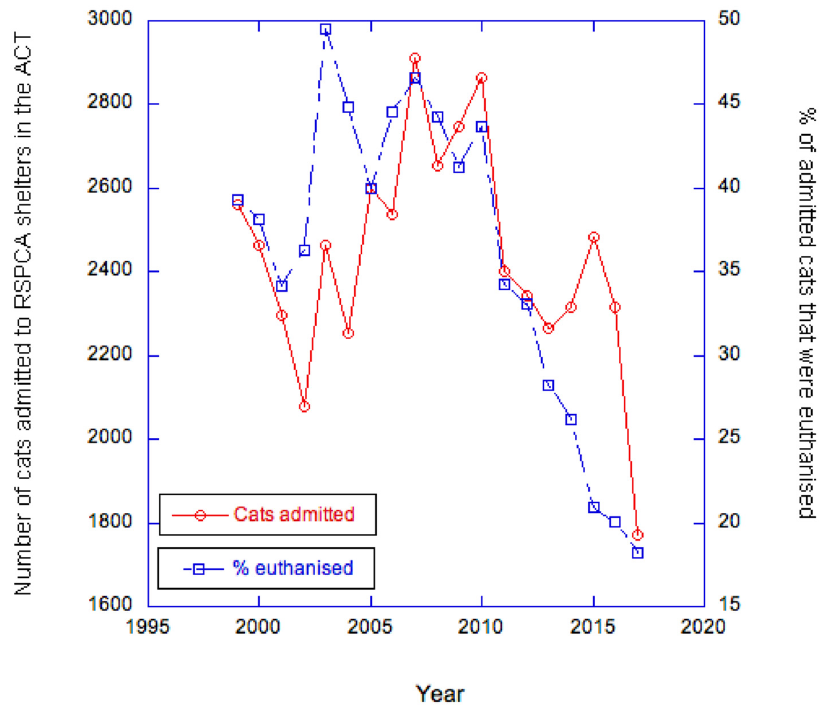
Figure 2. Cats admitted to RSPCA shelters in the Australian Capital Territory (ACT) and % of those cats euthanised between 1999/2000 and 2017/2018. Source: RSPCA Australia